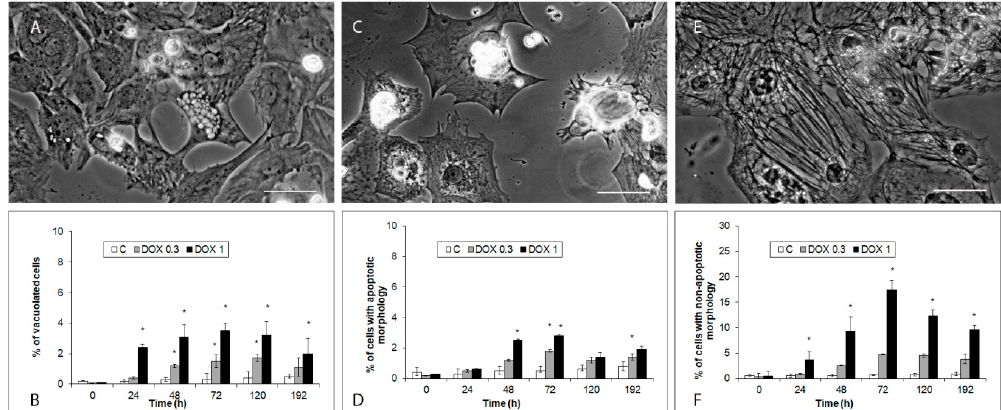
Figure 3. E ff ects of 1 and 0.3 µ M DOX on appearance of select morphologies in hiPCS-CMs Figure 3. Effects of 1 and 0.3 µM DOX on appearance of select morphologies in hiPCS-CMs cardiomyocytes during 192